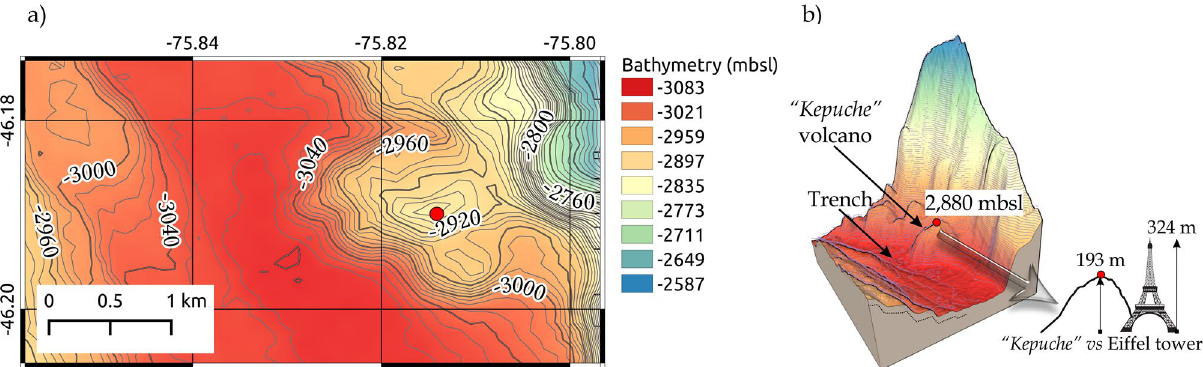
Figure 4. Regional setting of the area between the trench and the toe of the wedge. Bathymetry collected during the expedition MR08-06 and MR18-06 Leg2. ( a ) Contour map of the study area and the southern volcano. The red dot corresponds to the summit in meters below the sea level (mbsl); ( b ) 3-D zoom-in of the southern volcano, named “ Kepuche ”, the figures in the right corner represent an illustrative comparison of the height of the young volcano to the Eiffel tower. See text for more details. Figures generated using QGIS-v3.16.8 (https:// www. qgis. org/ en/